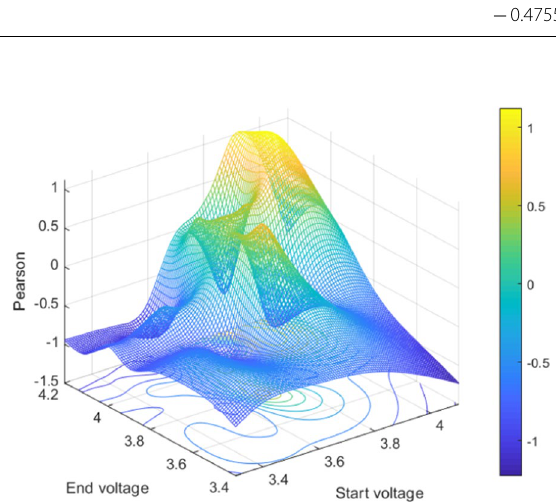
Fig. 6 Three-dimensional surface diagram of start voltage, end voltage and Pearson correlation